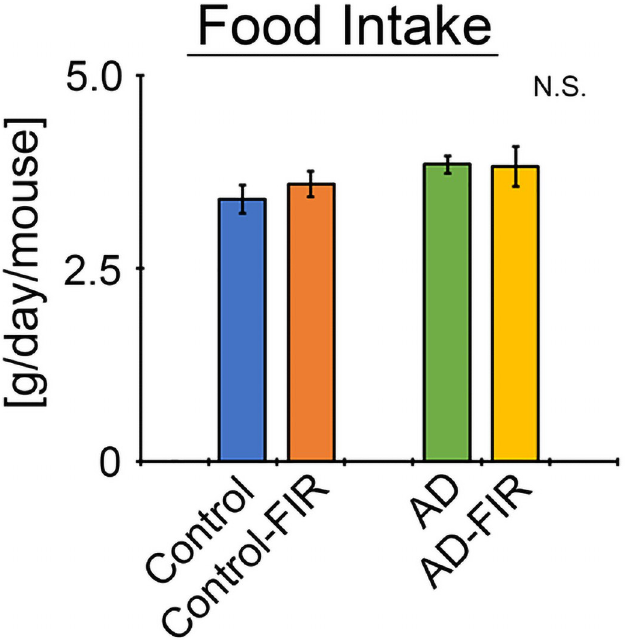
Fig 3. Daily mean food intake (g/day/mouse) in the presence and absence of FIR light. Food intake was measured once per week, and the mean per capita per diem consumption was calculated over the entire 5-month study period. Because all mouse groups were maintained on the same food pellets, daily caloric intake was not calculated separately. Data are expressed as means + SE (Control, n = 5; Control-FIR, n = 5; AD, n = 6; AD-FIR, n = 6). Comparisons in the presence or absence of FIR in both mouse groups were performed using a Tukey-Kramer’s test. N.S., not significant (p �